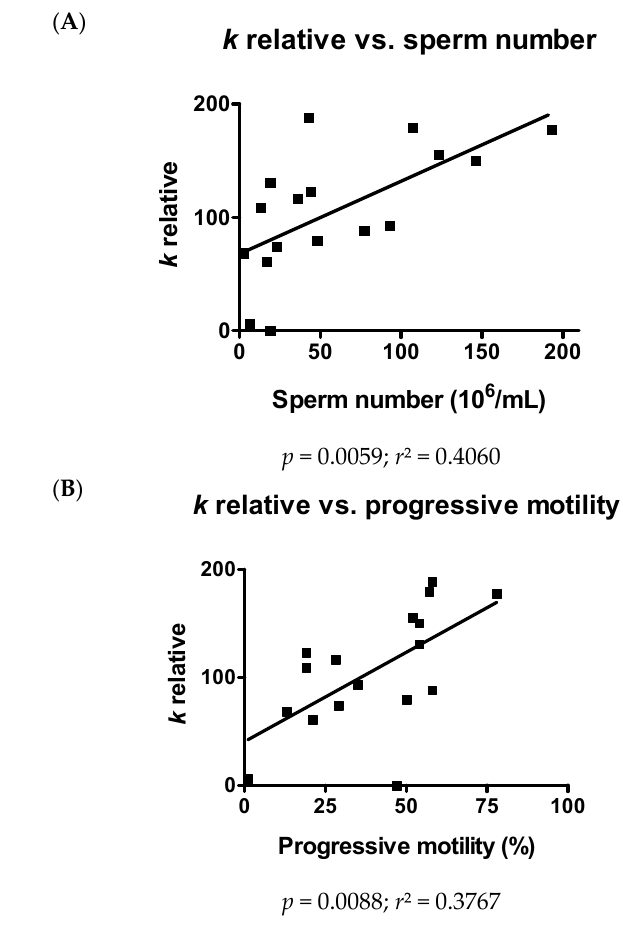
Figure 6. Relationship between osmotic water permeability and sperm number ( A ) or progressive motility ( B ) of human ejaculated semen from all normospermic and sub-fertile subjects. Water permeability of human ejaculated semen was measured by exposure to a 150 mOsm osmotic gradient. Values, expressed as k relative, are means of at least 15 single shots. Overall linear regression (black line) is presented. p and r 2 values are shown.